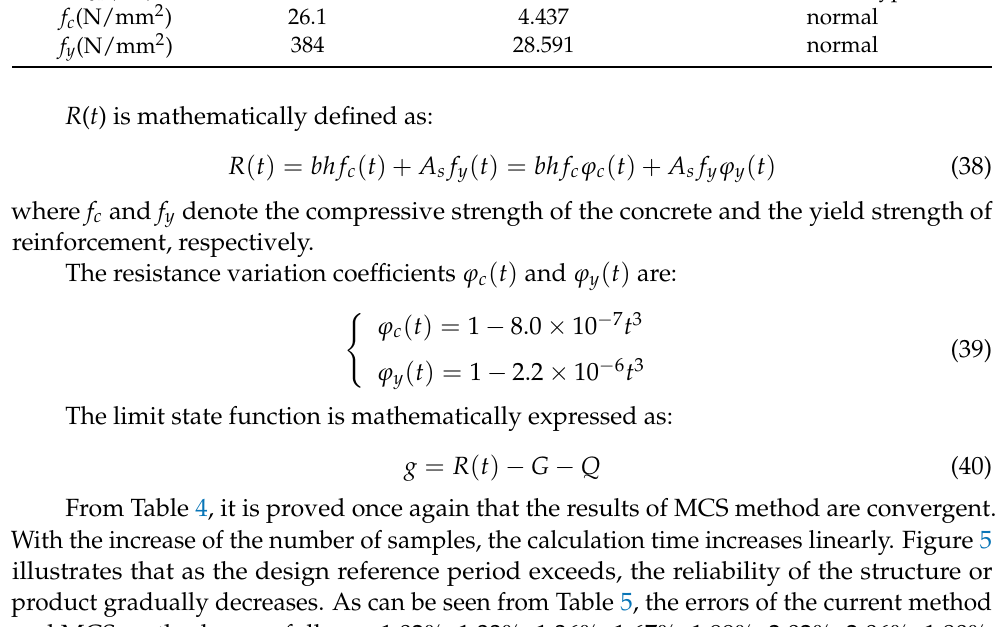
Table 3. Variable distribution of reinforced concrete short columns of a structure. Parameter Mean µ Standard Deviation σ Type of Distribution G (kN) 530